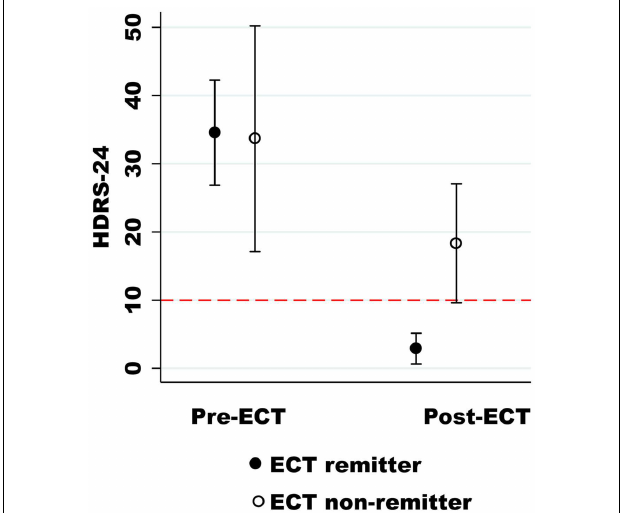
FIGURE 1 |The Hamilton Depression Rating Scale-24 (HDRS-24) is on the y -axis, and the pre- and post-ECT depression ratings are on the x -axis. The dashed red line (HDRS-24) differentiates ECT remitters from non-remitters.